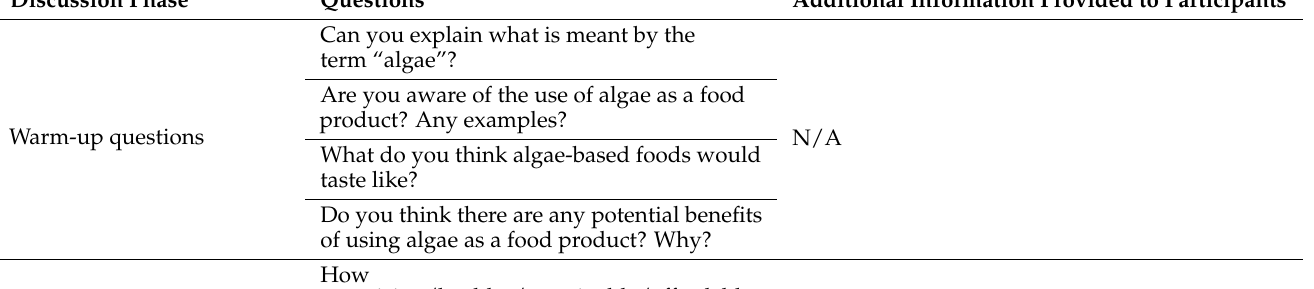
Table 1. Interview schedule for semi-structured focus